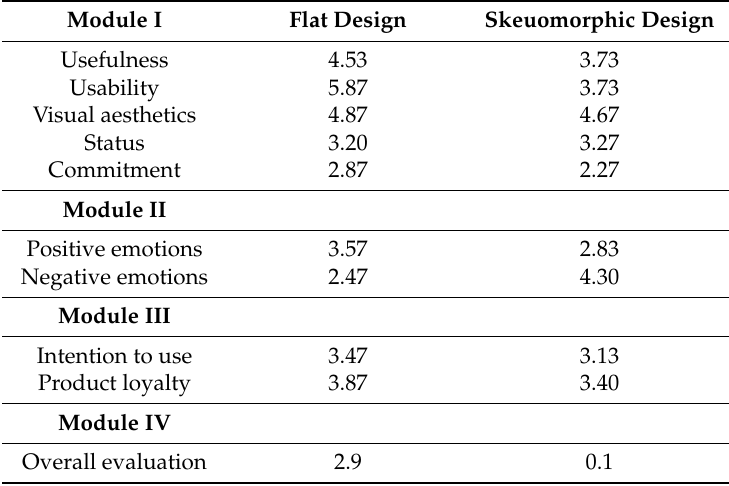
Table 14. meCUE scores for flat and skeuomorphic design.